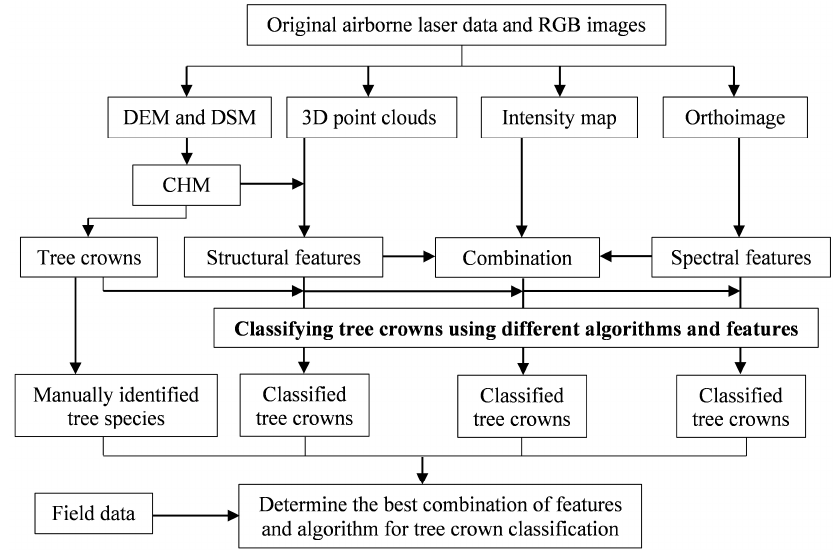
Figure 3. Research flow chart. DEM, digital elevation model; DSM, digital surface model; CHM, canopy height model.